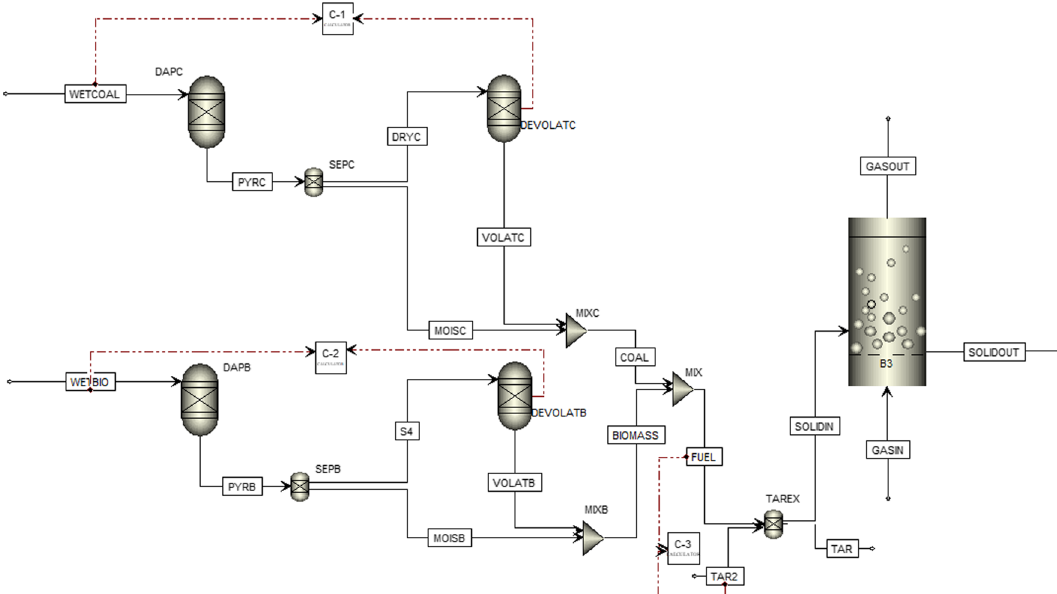
Fig. 1 The designed process model for coal/biomass combustion model in Aspen Plus v11